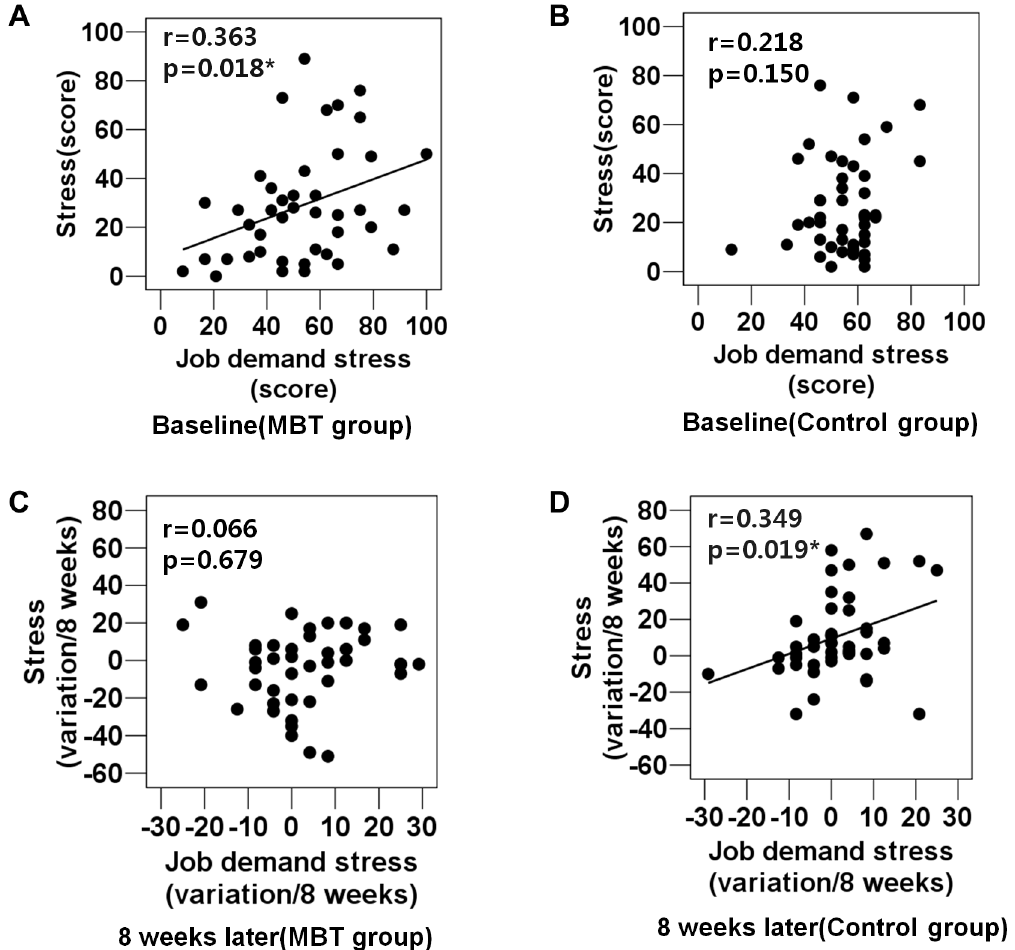
Fig 4. Correlations between job demand stress and perceived stress (SRI) in each group at baseline and in 8-week variations (scores subtracted baseline scores from 8-week scores). (A) A correlation between job demand stress and perceived stress (SRI) in the MBT group at baseline. (B) A correlation between job demand stress and perceived stress (SRI) in the control group at baseline. (C) A correlation between job demand stress (8-week variations) and perceived stress (8-week variations) in the MBT group. (D) A correlation between job demand stress (8-week variations) and perceived stress (8-week variations) in the control